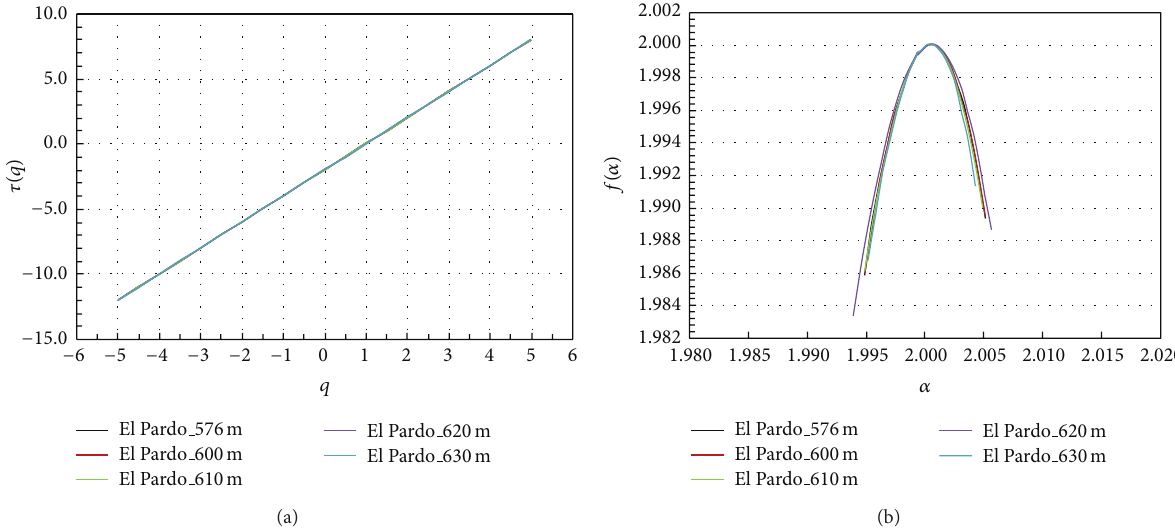
Figure 4: (a) Mass exponent function ( 𝜏(𝑞) versus 𝑞 ) and (b) multifractal spectrum ( 𝑓(𝛼) versus 𝛼 ) based on the original measure (altitude). Each colour represents the water reservoir at different filling levels.